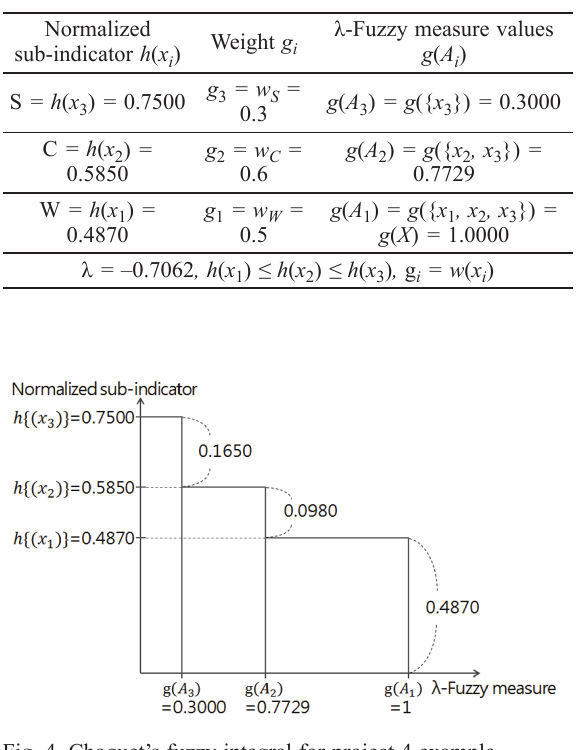
Fig. 4. Choquet’s fuzzy integral for project 4